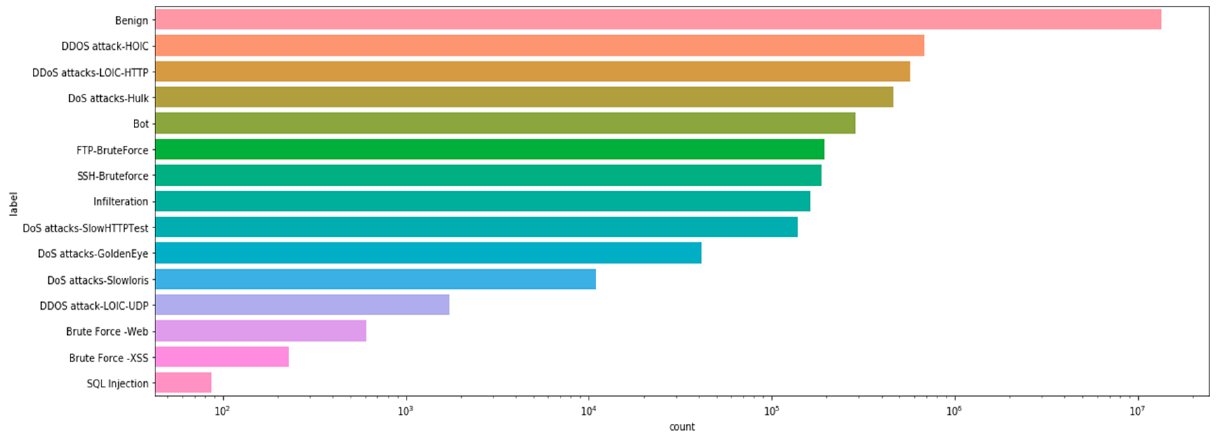
Figure 5. Number of flows/attack type.